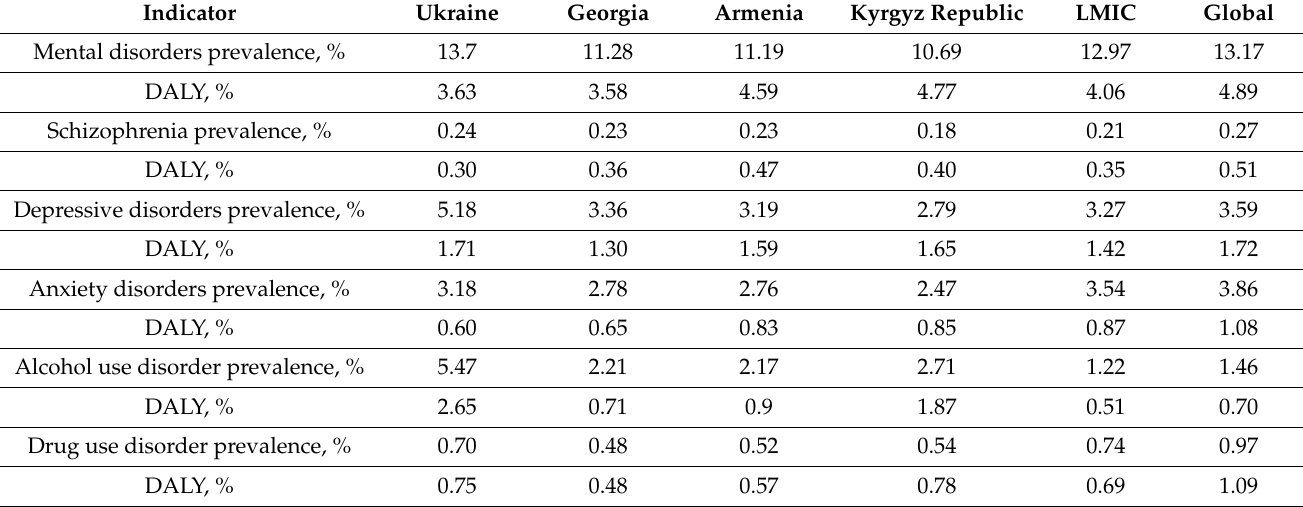
Table 2. Estimated prevalence and burden of mental health and substance use disorders in Ukraine, Georgia, Armenia, and Kyrgyz